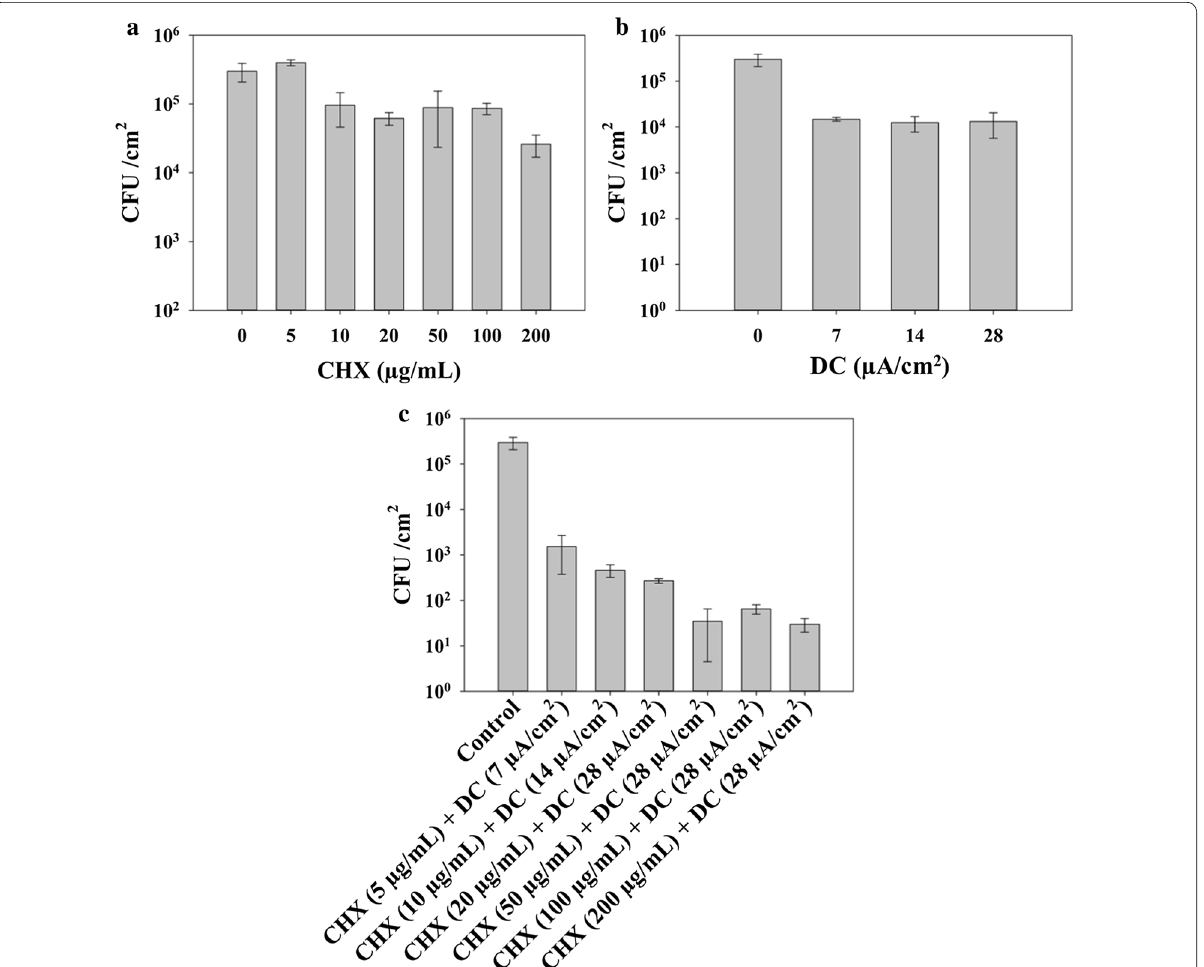
Fig. 1 Viability of S. mutans biofilm cells after 1 h treatment. a Treatment with CHX alone. b Treatment with DC alone. c Concurrent treatment with CHX and DC. All treatments were tested in 0.85% NaCl